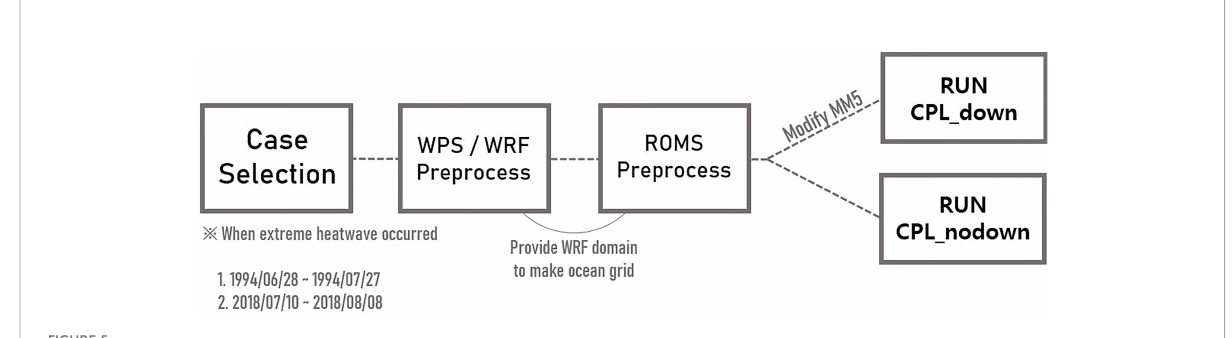
FIGURE 5 Schematic representation of the experimental